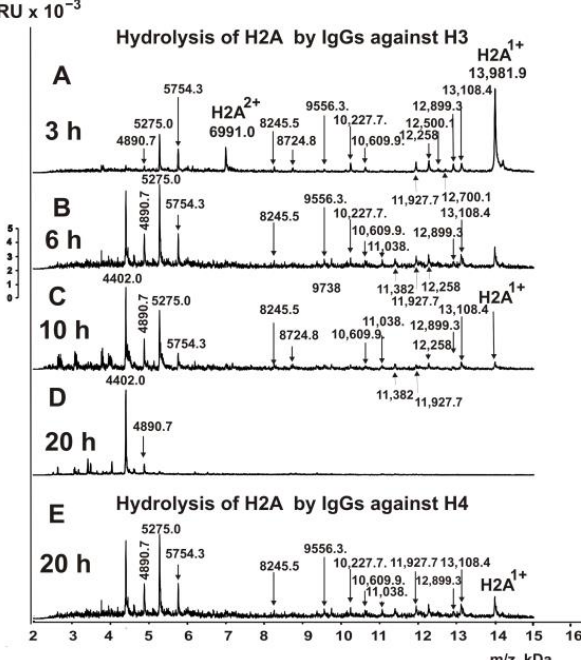
Figure 5. MALDI spectra demonstrating in time hydrolysis of H2A by IgGs (0.04 mg/mL) against H3 histone ( A – D ) and H4 histones ( E ).